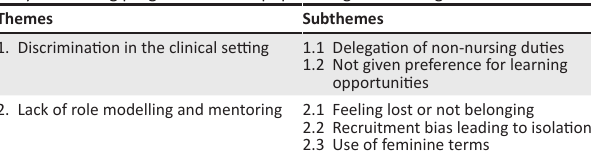
TABLE 1: Themes and subthemes on the experiences of male student nurses in a 4-year nursing programme in Limpopo College of Nursing.